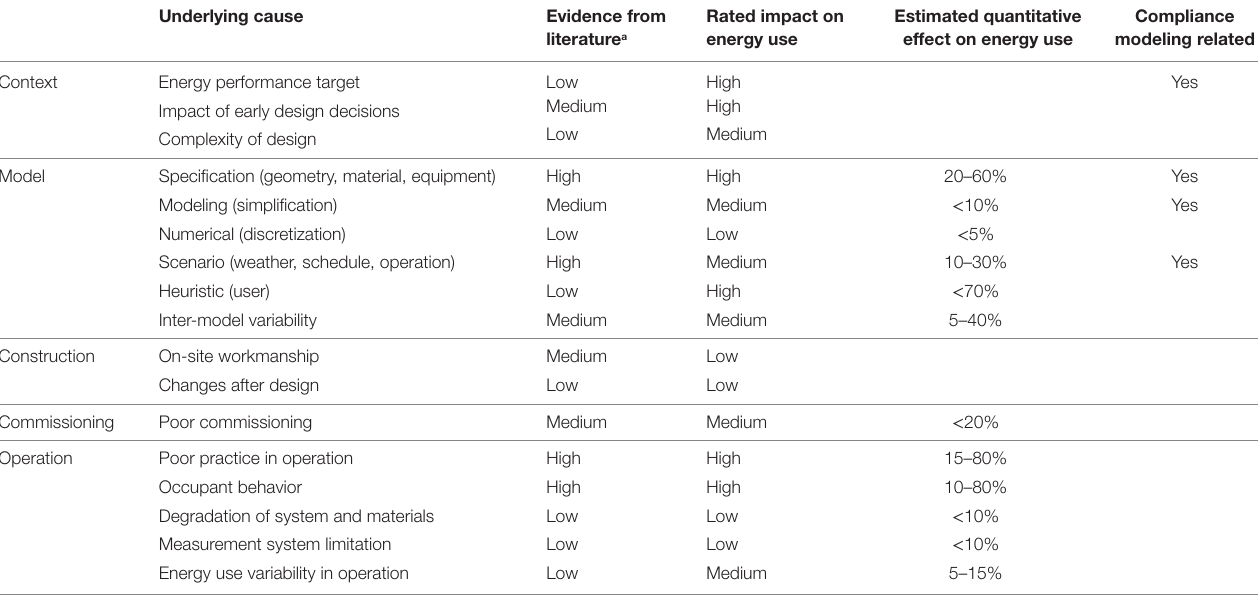
TABLe 3 | Potential risk on energy use from reported underlying causes assessed based on general consensus in the